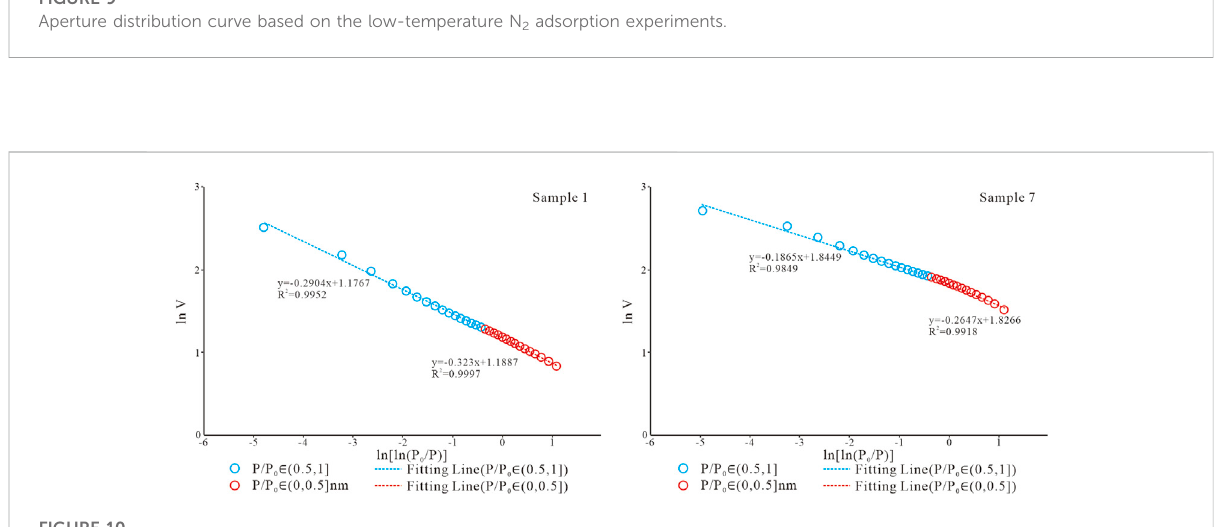
FIGURE 10 Fractal dimension calculation based on the FHH